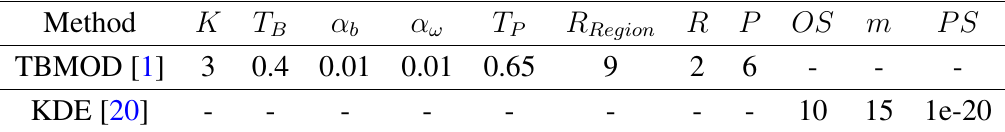
Table 3. Parameters for the experiment using both